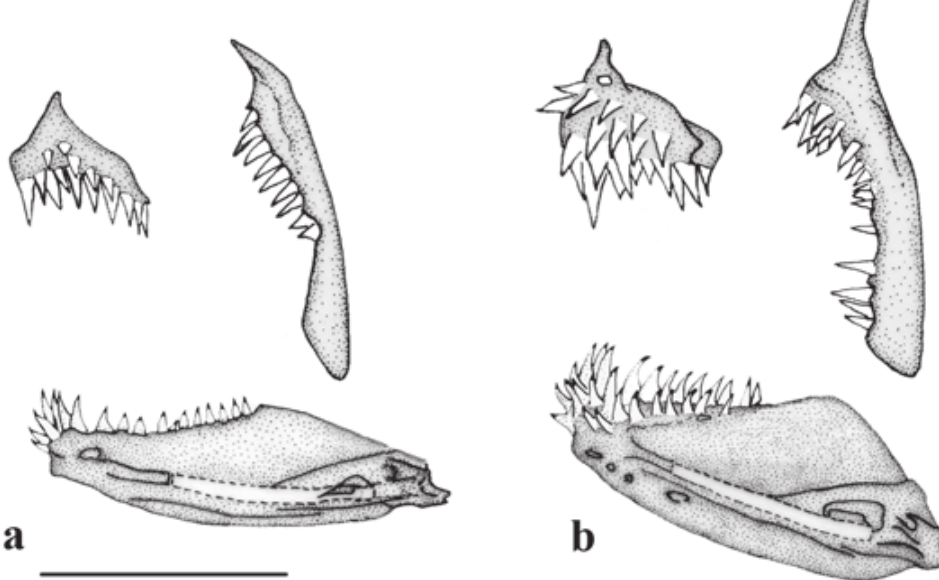
Fig. 3. Tyttocharax metae , paratypes, IUQ 2493, 18.4 mm SL. Maxilla, premaxilla and dentary, left lateral view. a) female; b) male; scale bar = 1 mm.